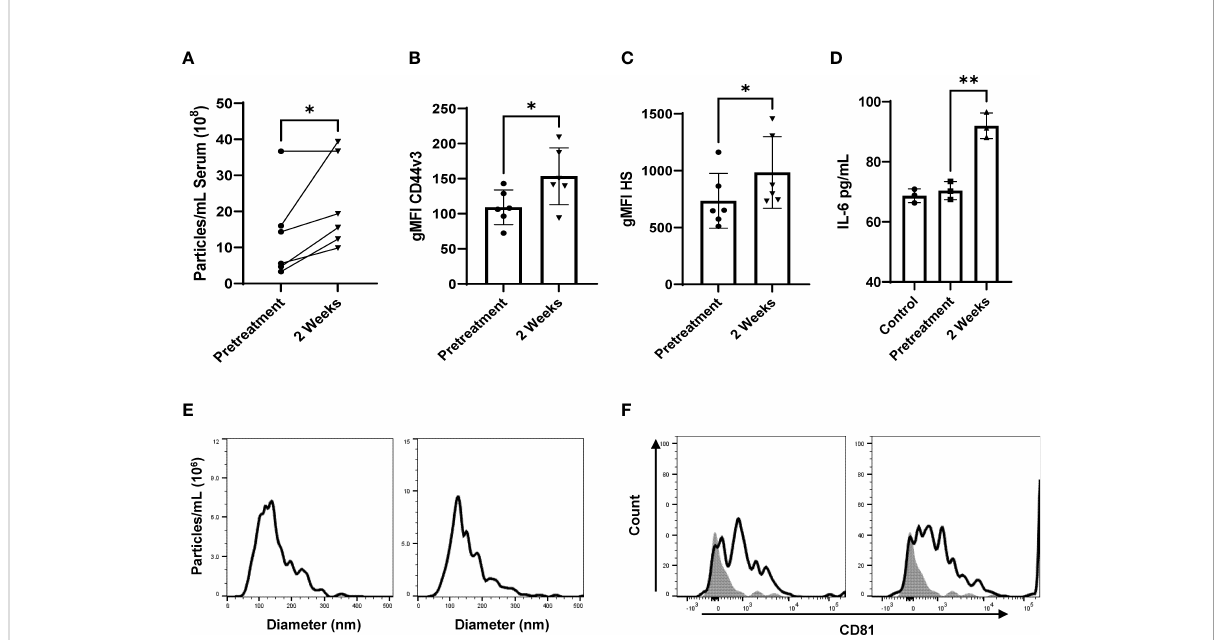
FIGURE 3 Radiation stimulates CD44v3 + IR-tEV circulation in breast cancer patients. (A) Total particle number of circulating breast cancer patient vesicles was assessed via particle tracking with the Zetaview Particle Tracker. (B, C) tEVs derived from breast cancer patient sera tEVs were bound to sulfoxide beads and HS and CD44v3 expression was measured via fl ow cytometry. Statistical signi fi cance for (a-c) was assessed with a paired T test. N=6. (d-h) Data points represent biological replicates. (D) MRC5 were incubated with tEVs collected and pooled from breast cancer patients. IL-6 levels were measured via ELISA Data points represent biological replicates. Statistical signi fi cance for was assessed with an unpaired T test. (E) The size distribution of tEVs collected from patients was assessed via particle tracking with the Zetaview Particle Tracker. (F) Expression of the exosomal marker CD81 was assessed via bead assisted fl ow cytometry. * denotes a P value < 0.05. These values were the results of ANOVA analyses performed on